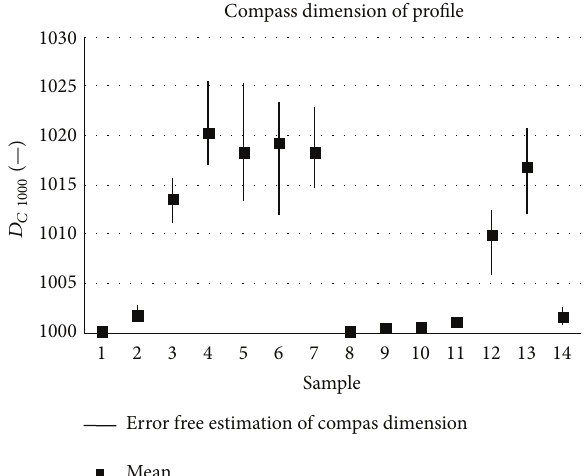
Figure 7: Results of 𝑃 𝑡 parameter ( 𝑥 -axis).